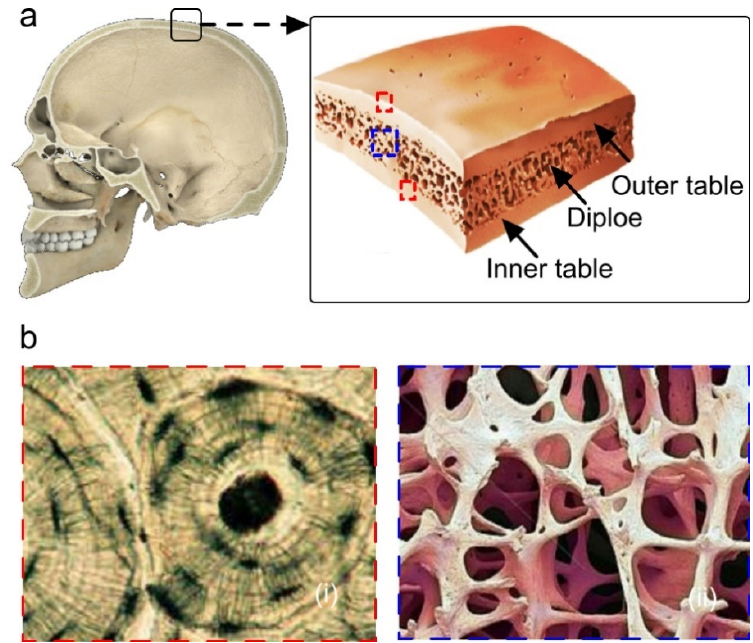
Figure 1. Skull bone structure. ( a ) Structural component of human skull bone, each layer magnified in ( b i) the outer tables and ( b ii) diploe. ( b i) the outer tables and ( b ii)